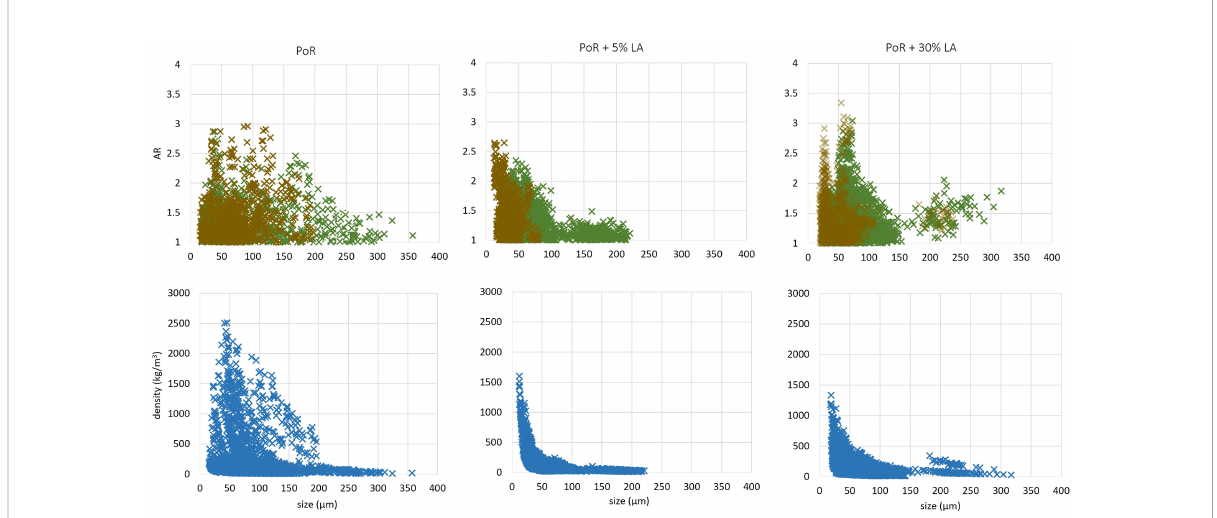
FIGURE 9 Top panel: Aspect Ratio (AR) as function of equivalent diameter. The brown color represents particles of effective density larger than 160 kg m − 3 and the green colour particles of density lower than 160 kg m − 3 . Bottom panel: absolute density as function of equivalent diameter. The data is obtained by LabSFLOC2